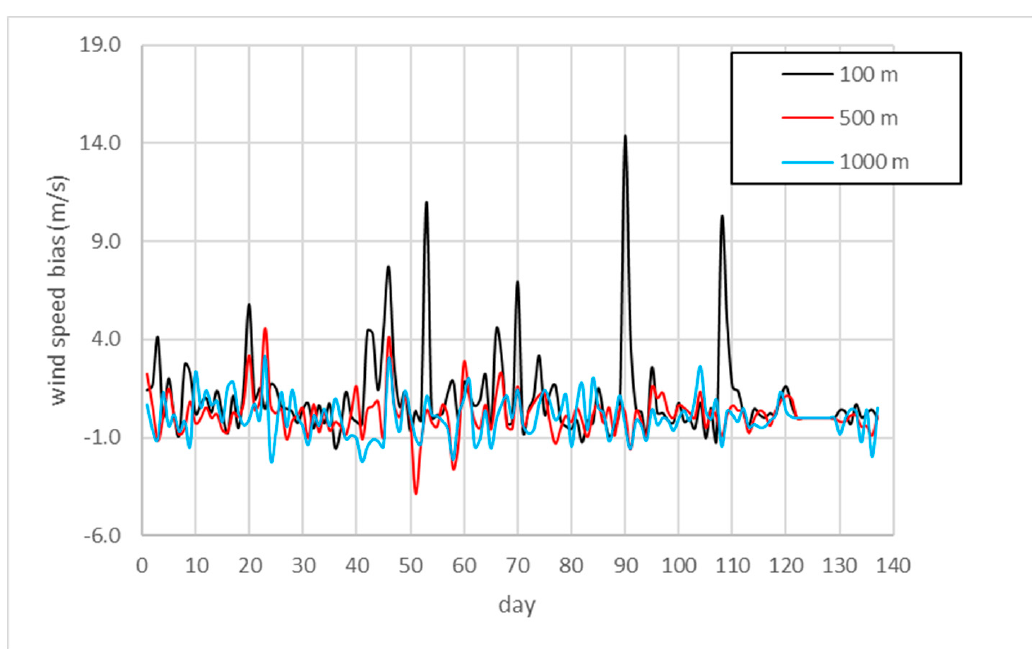
Figure 8. Time series of daily wind speed bias values (m/s) against wind profiler data over the considered period at 100, 500 and 1000 m. Model data are related to the nearest grid point, while in the vertical directions, levels have been interpolated to the instrument values. Table 4. Average, maximum and minimum values of BIAS at 100, 500 and 1000 m for wind speed (m/s) and direction (degrees). Average, maximum and minimum values of RMSE for wind speed (m/s) and direction (degrees). Index of agreement d (non-dimensional). CORR and STD_RATIO indicators (non-dimensional).